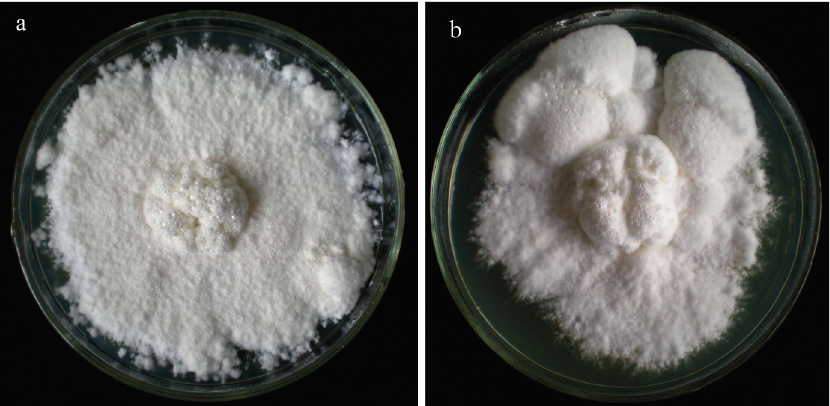
Figure 1. Inducing sclerotial formation under artificial conditions. ( a ) Mycelia could not form sclerotia; ( b ) sclerotial formation after 60 days